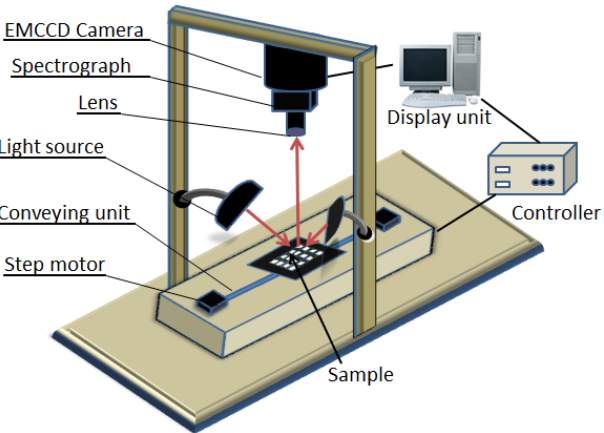
Figure 1. Hyperspectral imaging